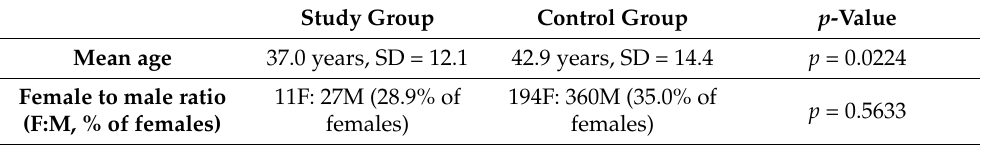
Table 1. Demographics of study group and control group for the PCL envelope lack sign (PELS). Study Group Control Group p -Value Mean age 37.0 years, SD = 12.1 42.9 years, SD = 14.4 p = 0.0224 Female to male ratio 11F: 27M (28.9% of 194F: 360M (35.0% of p = 0.5633 (F:M, % of females) females) females) SD—standard deviation, M—males, F—females.